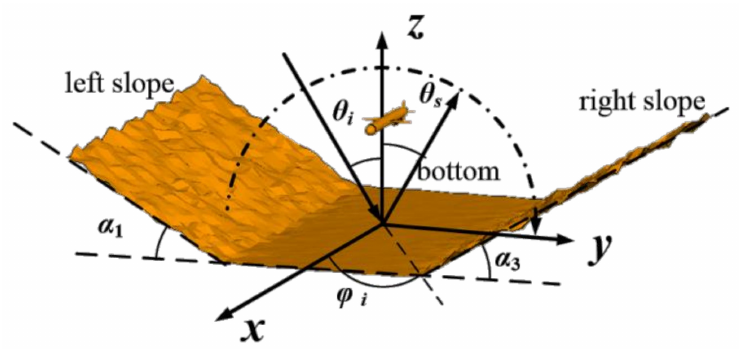
Figure 12. The geometry of the missile-like target above composite rough surface.